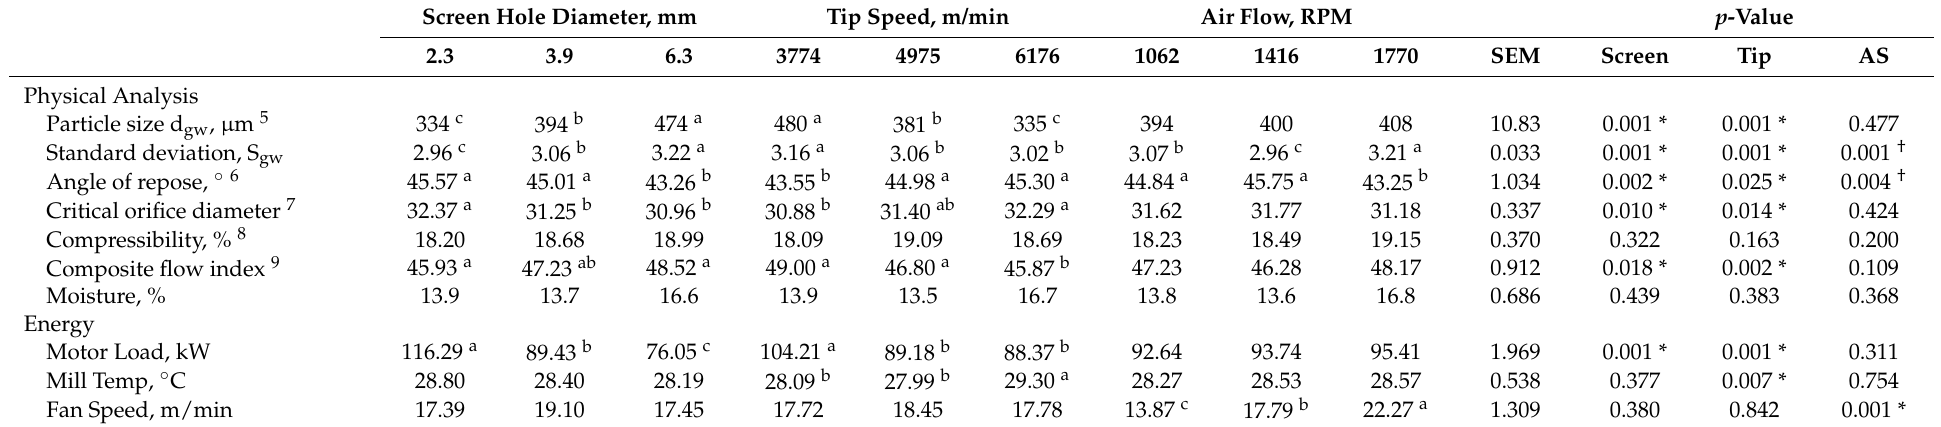
Table 4. Influence of main effects of screen hole diameter, tip speed, and air flow on energy consumption, particle size, and flowability of hammermilled corn 1,2,3,4